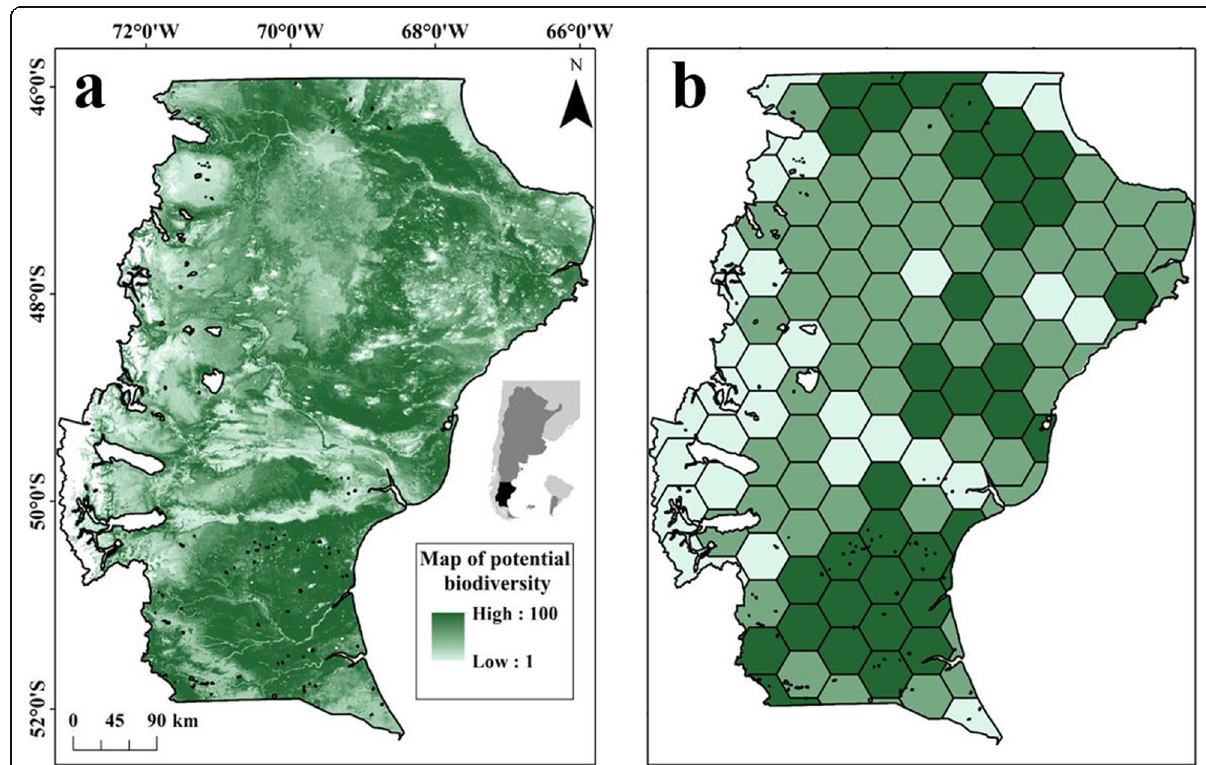
Fig. 4 Potential biodiversity map (PBM) based on 53 indicator vascular plant species for Santa Cruz Province ( a ) and summarized hexagons of 250 thousand ha ( b ). In the left graph, higher intensity colour represents greater potential biodiversity, while in the right graph, hexagons are classified in three levels of mean potential biodiversity: low potential = pale green (1 – 51%), medium potential = green (52 – 62%), and high potential = dark green (63 –